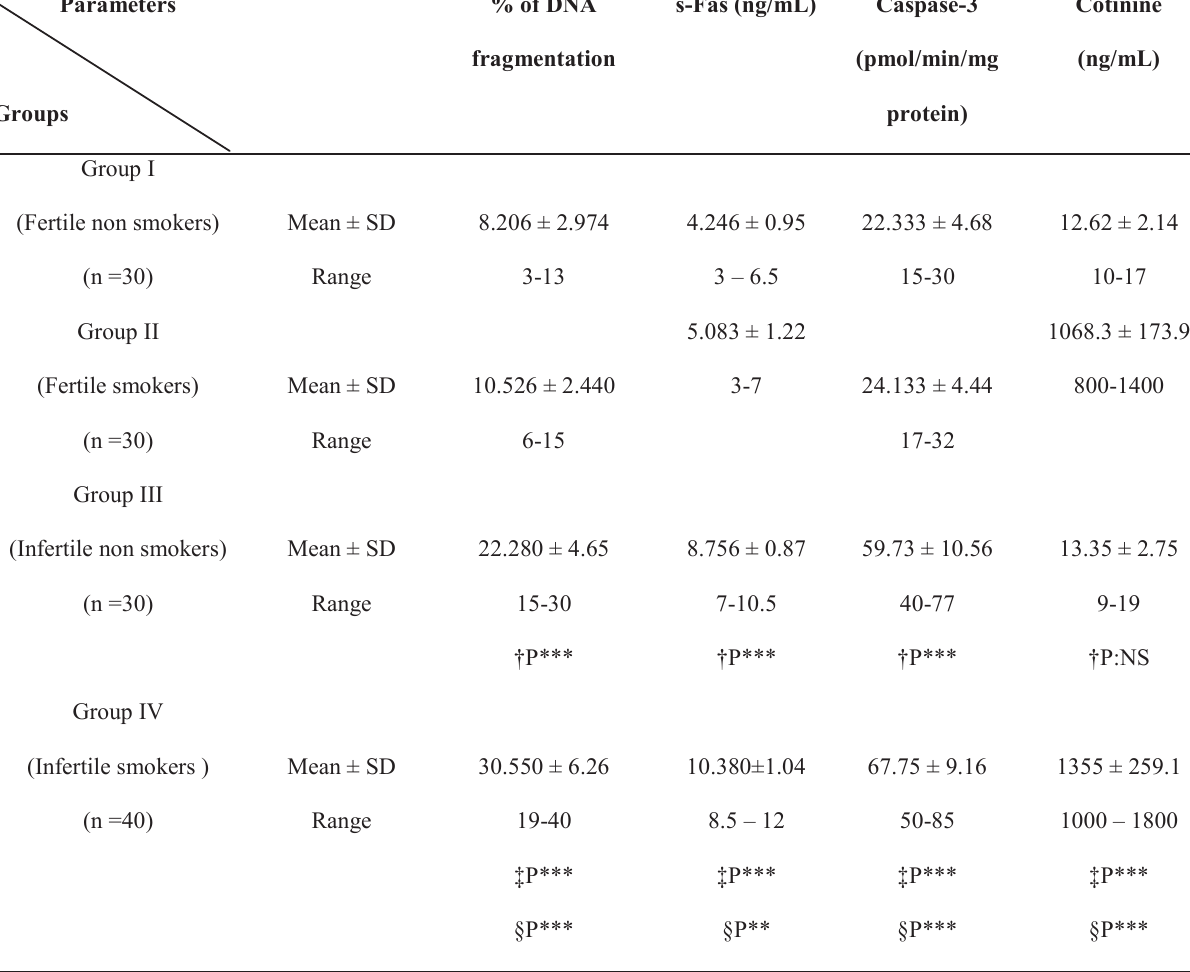
Table 2. Plasma levels of % of DNA fragmentation, s-Fas, Caspase-3 activity and cotinine in infertile men and fertile controls.